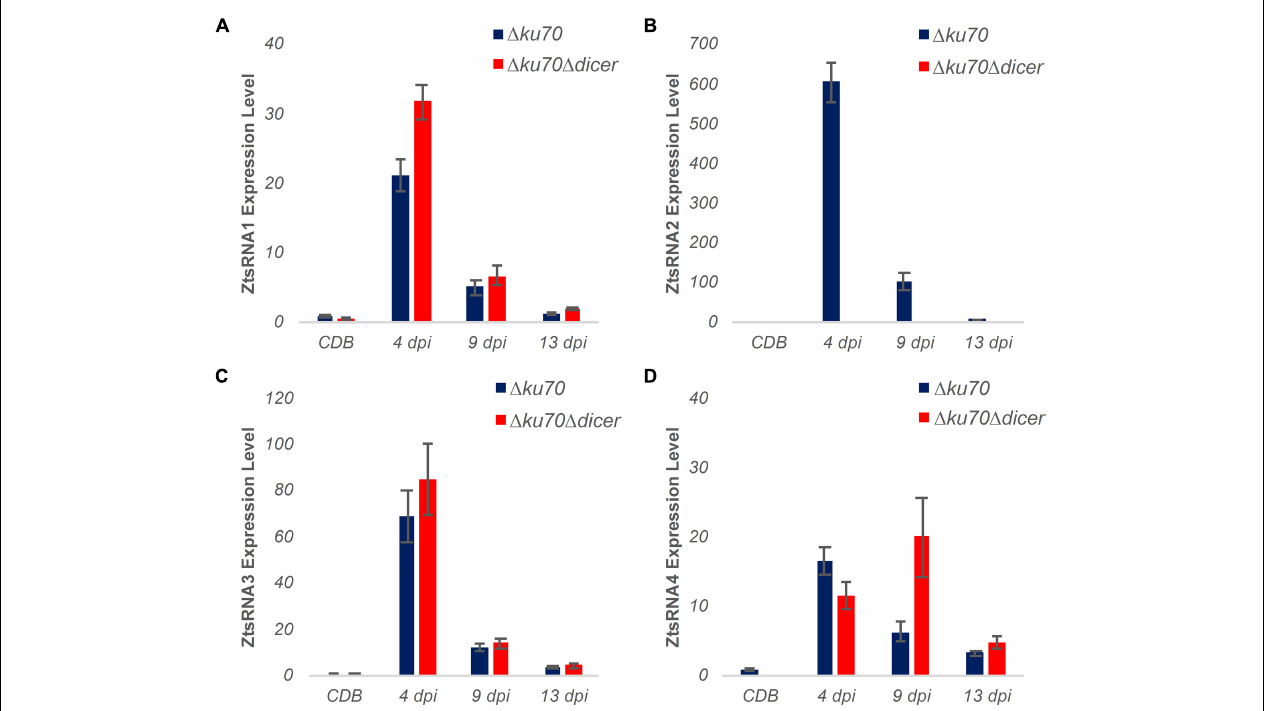
FIGURE 5 | Expression profiling of fungal sRNAs in an RNAi-deficient Zymoseptoria tritici mutant (cid:49) dicer (IPO323 (cid:49) ku70 (cid:49) dcl ). (A–D) Stem-loop qRT-PCR analysis of four ZtsRNAs from Z. tritici IPO323 (cid:49) ku70 (blue) and Z. tritici IPO323 (cid:49) ku70 (cid:49) dcl (red). Fungal material from an in vitro culture (Czapek-Dox Broth, CDB) and in planta (leaf tissue at 4, 9, and 13 days post-inoculation, dpi) was assessed. There were 3 biological replicates in this experiment. Bars represent the mean and SE. The Z. tritici IPO323 (cid:49) ku70 (CDB) samples were set to 1 in all panels.